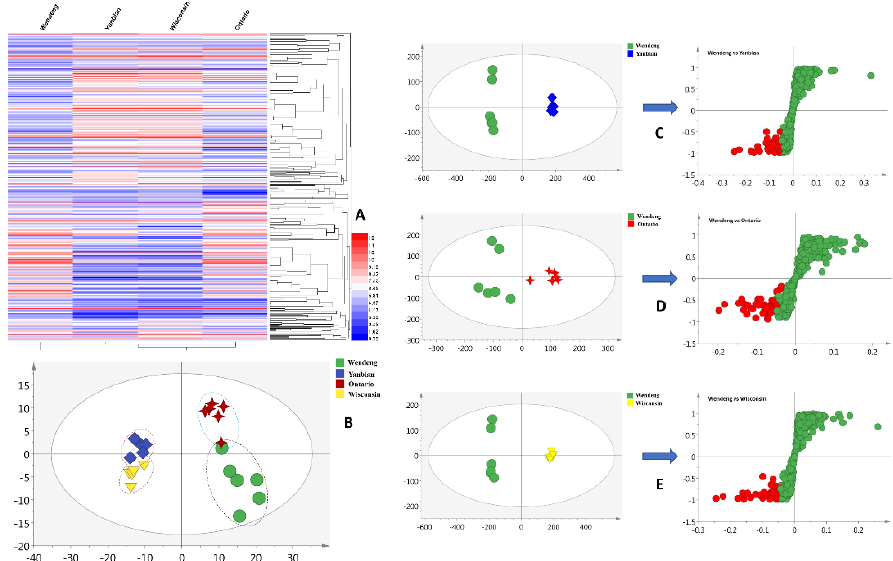
Figure 1. Metabolic profiling of P. quinquefolius grown in four different regions. ( A ) Heatmap showing the relative abundance values of all metabolites; ( B ) PCA analysis; ( C ) OPLS − DA plots of the Wendeng and Yanbian species; ( D ) OPLS − DA plots of the Wendeng and Ontario species; ( E ) OPLS − DA plots of the Wendeng and Wisconsin species.